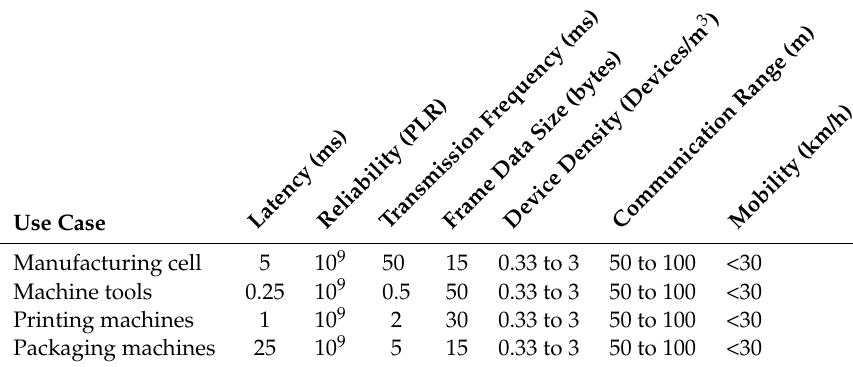
Table 1. Network characteristics of IoT devices in factory